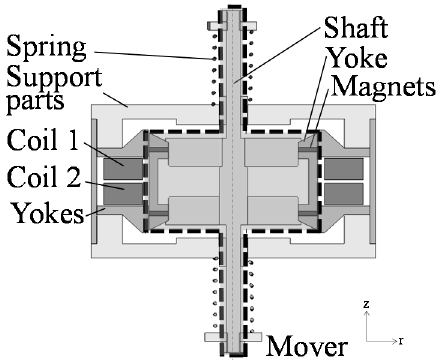
Figure 3. Basic construction of proposed actuator.